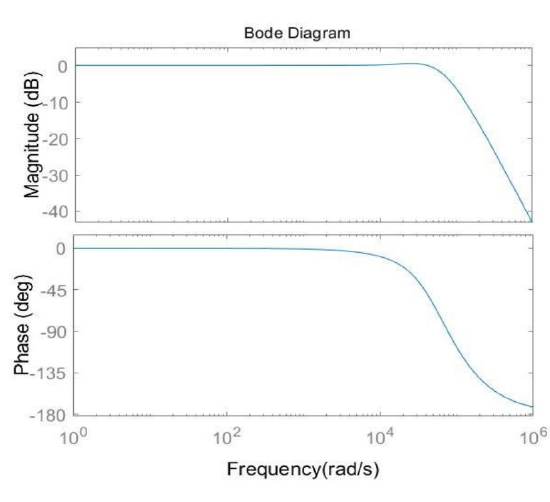
Fig. 4. Current control block diagram.